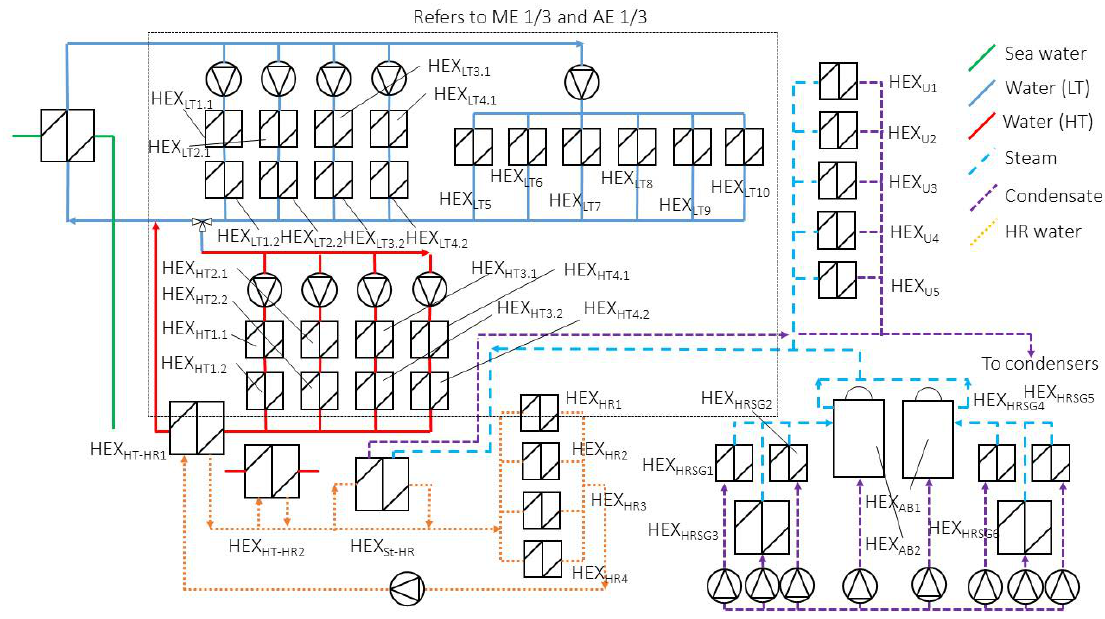
Figure 5. General view of the ship heating and cooling systems. The full list of heat exchangers in the heat exchanger network is provided in Appendix A.5 in Table